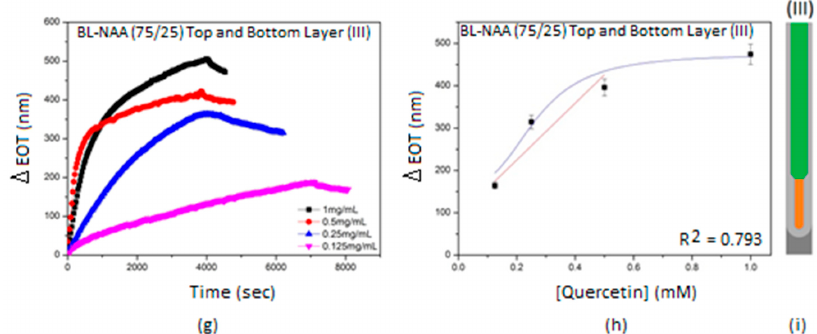
Figure 7. Time response curve showing effective optical thickness changes and fitting curves for BL-NAA (75/25) (funnel structure with longer top layer with large diameters and shorter bottom layer with smaller pore diameters) sensing platforms measured by RIfS as a function of quercetin concentration (0.125, 0.25, 0.5, and 1 mM). ( a ) Δ EOT (I) generated from top structural layer of BL-NAA (75/25) platform; ( b ) Linear fitting line for BL-NAA (75/25) between Δ EOT (I) and the different concentration of quercetin (0.125, 0.25, 0.5, and 1 mM); ( c ) Scheme of representative optical layer as a function of Δ EOT (I) assessment; ( d ) Δ EOT (II) generated from bottom structural layer of BL-NAA (75/25) platform; ( e ) Sigmoid fit (blue) and the linear fit (red) for BL-NAA (75/25) between Δ EOT (II) and the different concentration of quercetin (0.125, 0.25, 0.5, and 1 mM) are presented; ( f ) Scheme of representative optical layer as a function of Δ EOT (II) assessment; ( g ) Δ EOT (III) generated from the top and bottom nanoporous structure of the BL-NAA (75/25) platform; ( h ) Sigmoid fit (blue) and the linear fit (red) for BL-NAA (75/25) between Δ EOT (III) and the different concentration of quercetin (0.05, 0.125, 0.25, 0.375, 0.5, and 1 mM) are presented; ( i ) Scheme of representative optical layer as a function of Δ EOT (III) assessment. Table 3. Result of sensing performance of BL-NAAs and NAAs by ∆ EOT measurement.